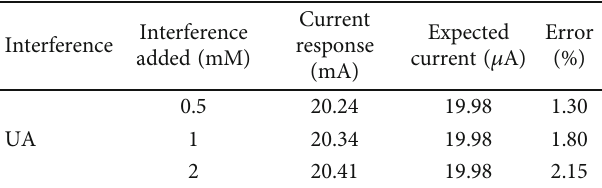
Table 3: Summary of intereference study of AA with various concentrations of